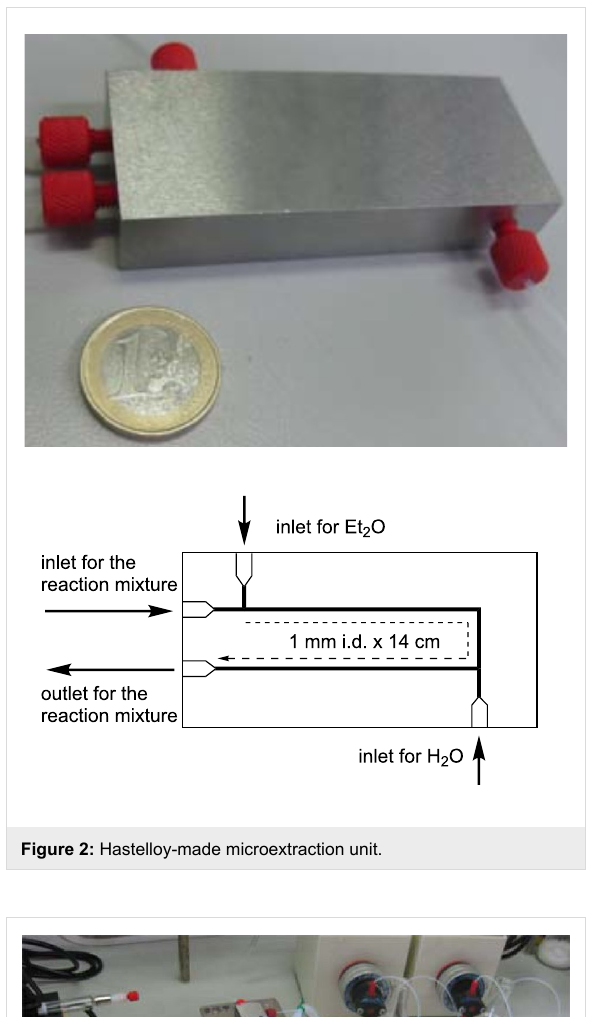
Figure 2: Hastelloy-made microextraction unit.